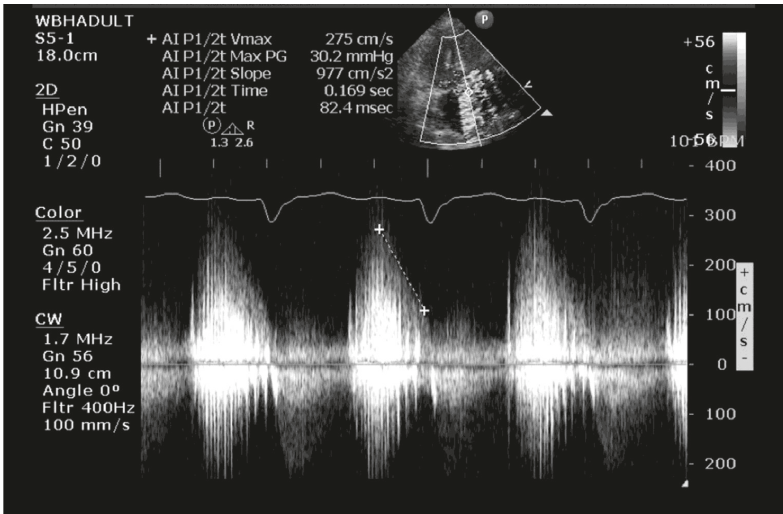
Figure 1: Transaortic Doppler demonstrating dense aortic regurgitation signal with markedly reduced pressure half time, suggestive of severe aortic